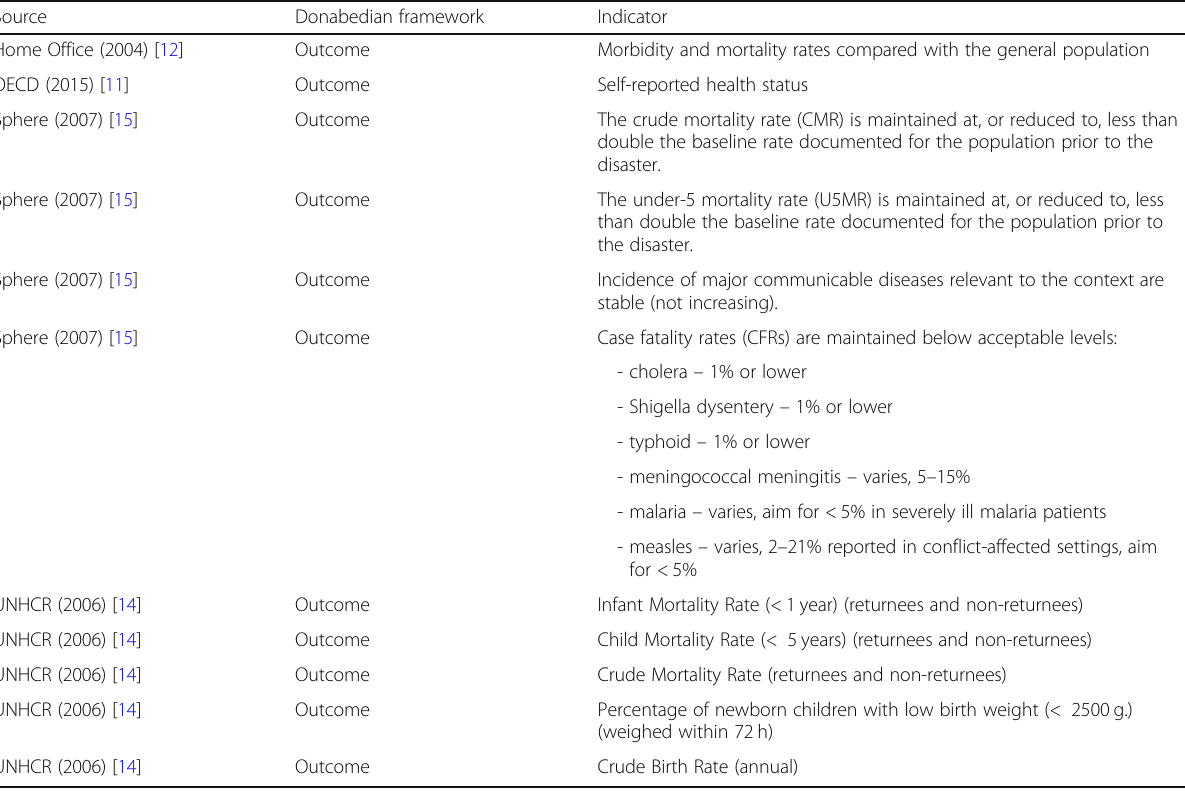
Table 4 Indicators for the topic health status Source Donabedian